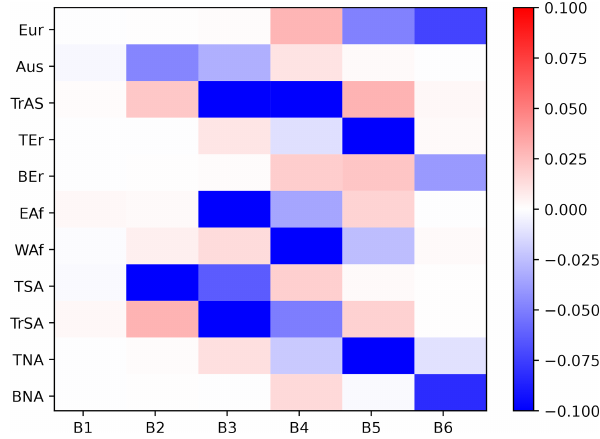
Figure 5. A posteriori error correlation between OH scaling factors for six latitude bands (75–50 ◦ S, 50–25 ◦ S, 25–0 ◦ S, 0–25 ◦ N, 25– 50 ◦ N, 50–75 ◦ N) and emissions for 13 regions (Fig.